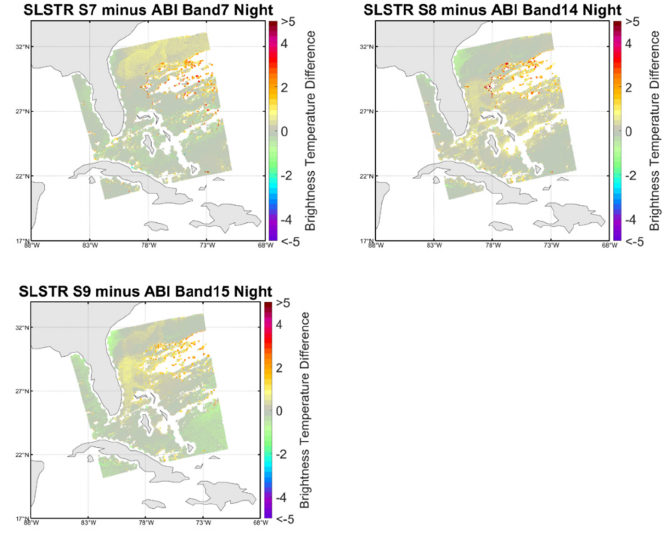
Figure 6. ( a ): SLSTR nighttime false color infrared image of the eastern tropical North Atlantic Ocean coast region on 1 January 2020, 02:55:20 UTC. ( b ): Solar zenith angles at the same time. ( c ): Corresponding SLSTR satellite zenith angles. ( d ): Corresponding ABI satellite zenith angles, only the points with available ABI matched up pairs are shown.